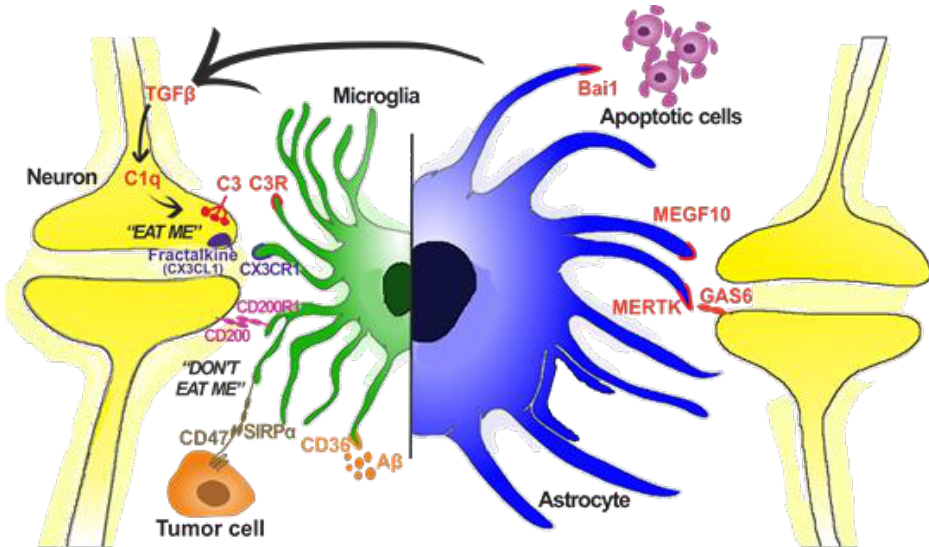
Figure 1. Graphical representation of different phagocytic receptors and ligands in microglia and astrocytes. Although microglia are considered the professional phagocytic cell of the brain, astrocytes are also able to modulate neuronal synapsis. In the case of microglia, there are stimuli for both “eat me” and “don’t eat me” signals. Apart from neurons, they are also able to modulate tumor cells (microglia), apoptotic cells (both), and A β intake (microglia and in vitro astrocytes). Based on [122,133–135].